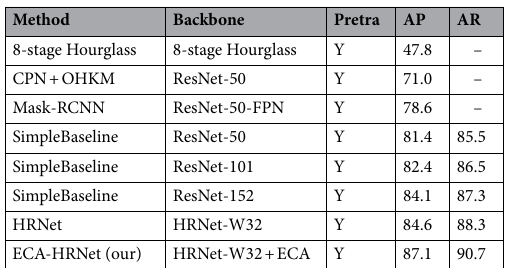
Table 5. Comparison of results on KDSJ validation set (Pretra = backbone pretrained on the COCO2017 keypoint task; OHKM = online hard keypoint mining 8